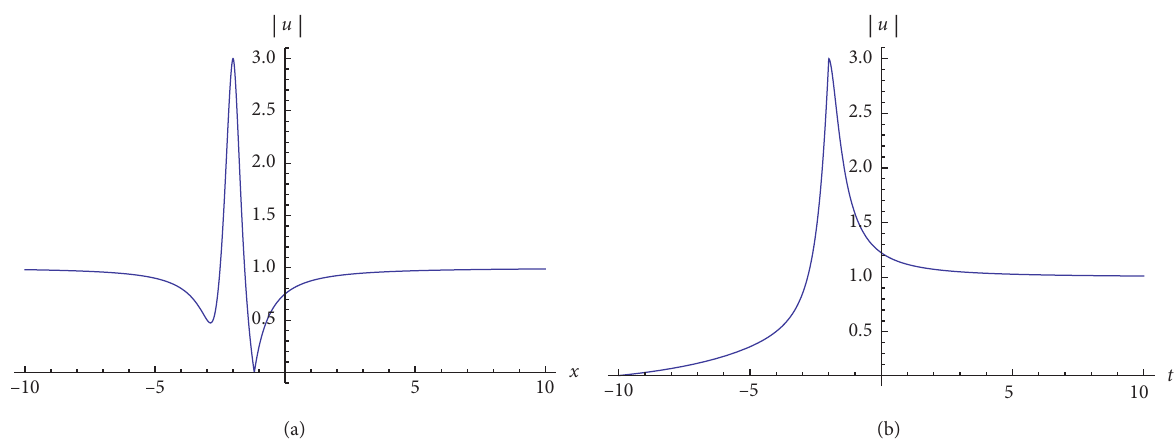
Figure 13: Amplitude and dynamic evolution of the asymmetric first-order fractional rogue wave with α � 9/10 and a � − 2 modified from solution (33). (a) t � − 2. (b) x � −